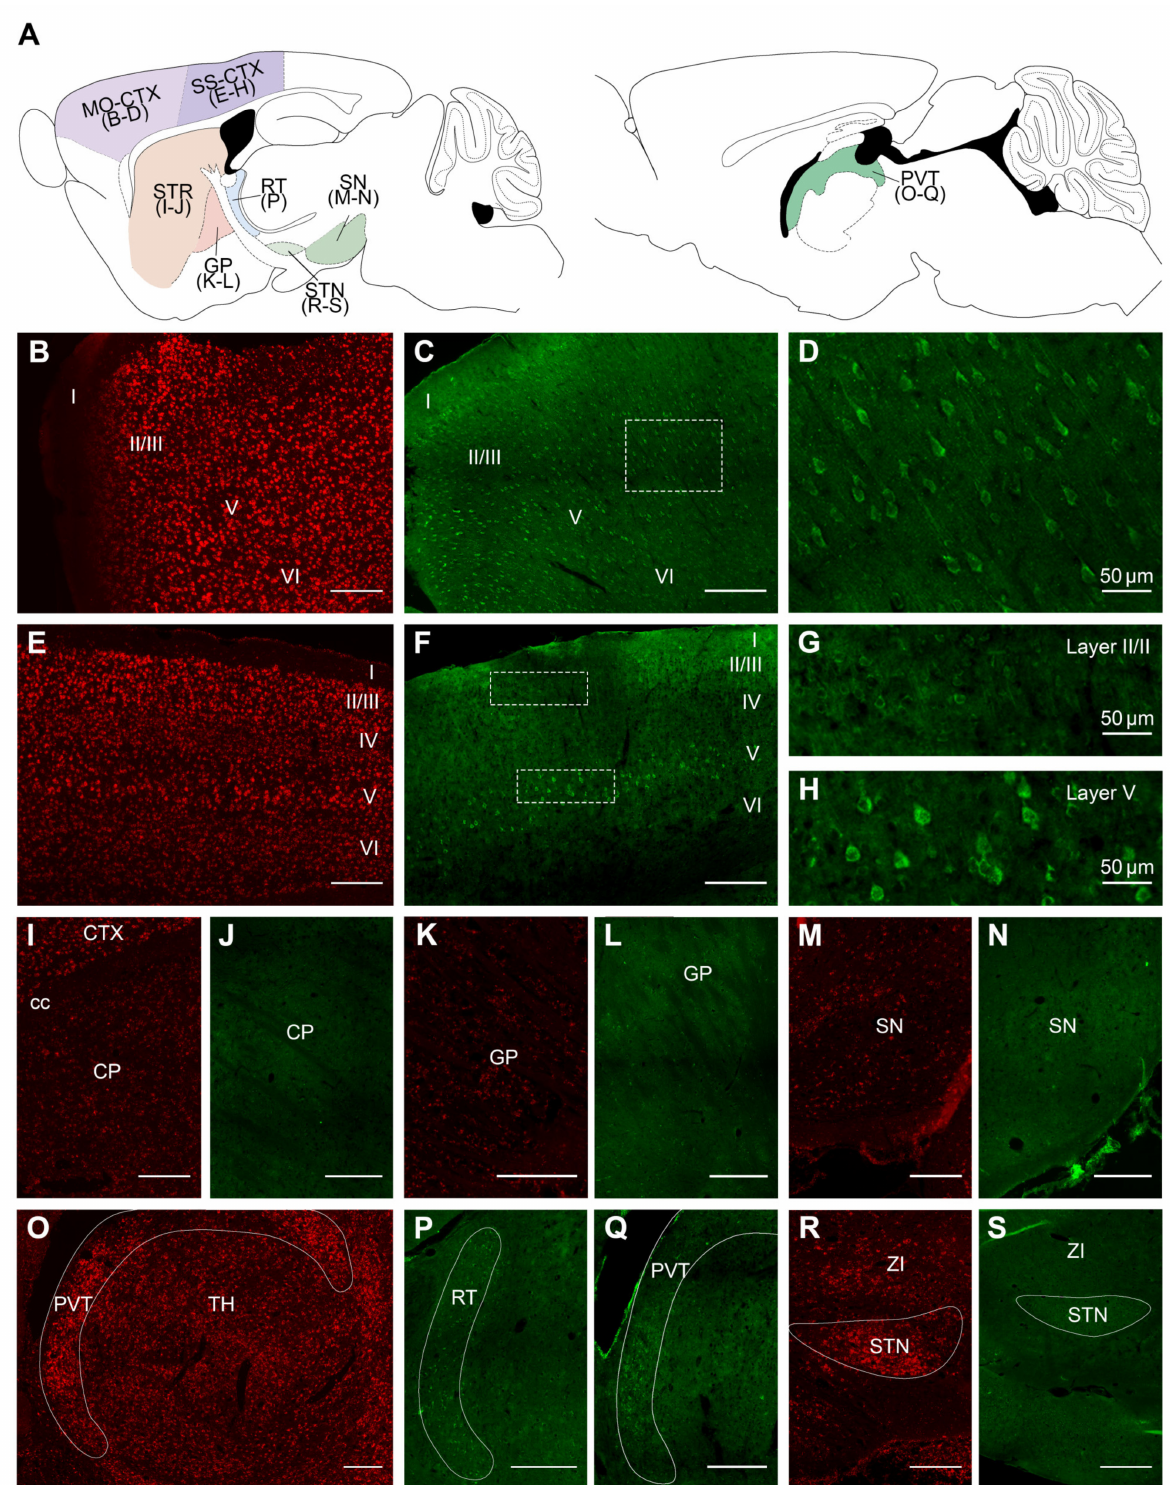
Figure 2. VPS13A mRNA and protein are widely localized in the cortex and basal ganglia-related nuclei of the adult mouse brain. ( A ) Drawings with the location of the different brain regions shown in ( B – S ). Specific labeling of VPS13A mRNA